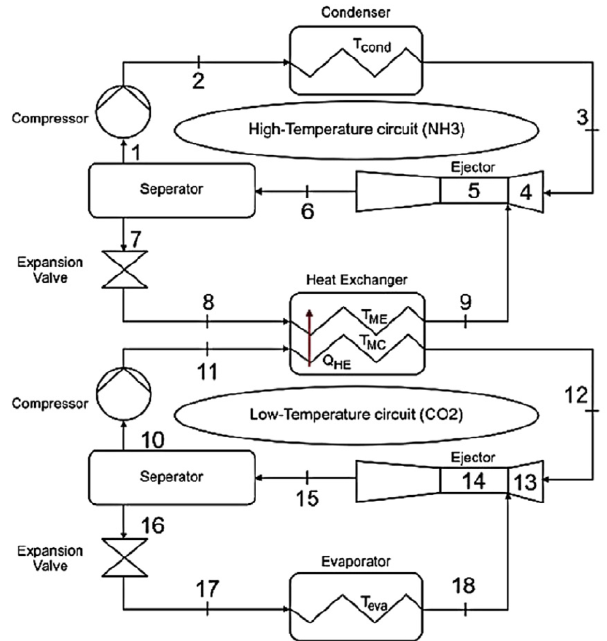
Figure 3. The process of a novel ejector–expansion CO 2 /NH 3 cascade refrigeration cycles [12]. Reproduced with permission from [Elsevier], Elsevier, 2020.